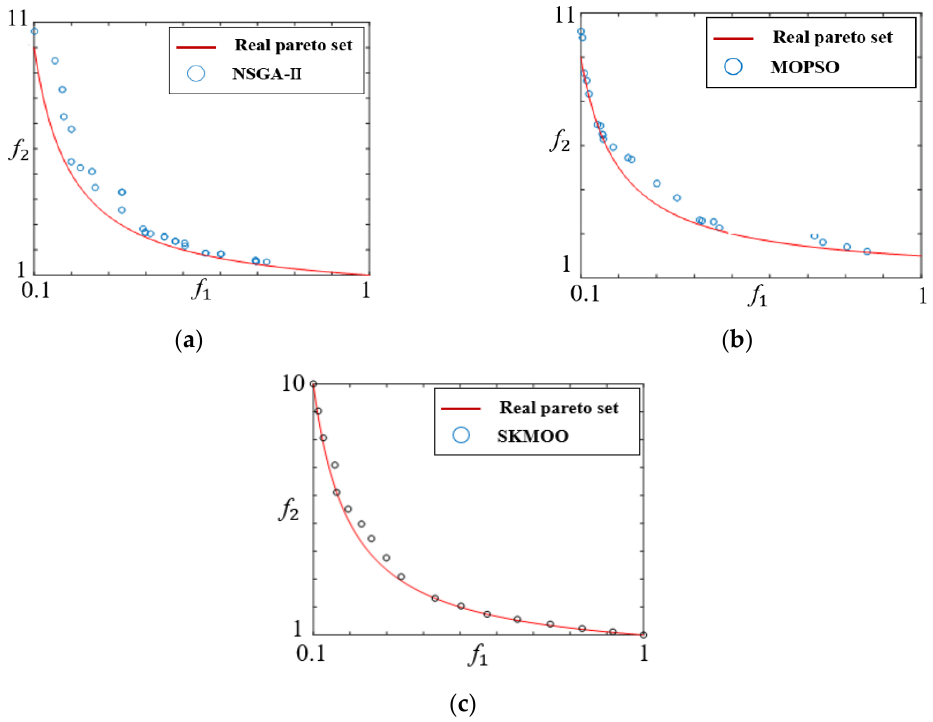
Figure 5. Pareto front set of test function1 ( a ) NSGA-II; ( b ) MOPSO; ( c ) SKMOO.